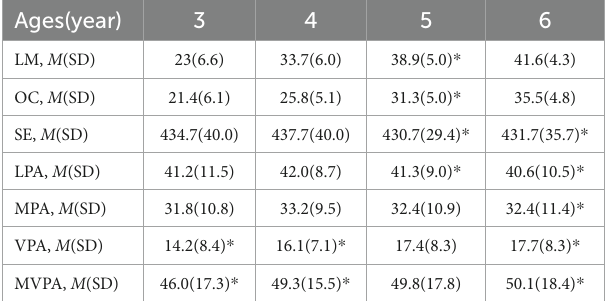
TABLE 2 Participants’ FMS, SE, and PA.